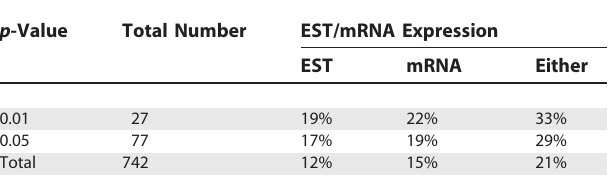
Table 6. Percentage of Expressed Pseudogenes in Relation to Their Conservation p -Values (Calculated with Hoeffding’s Bound) p -Value Total Number